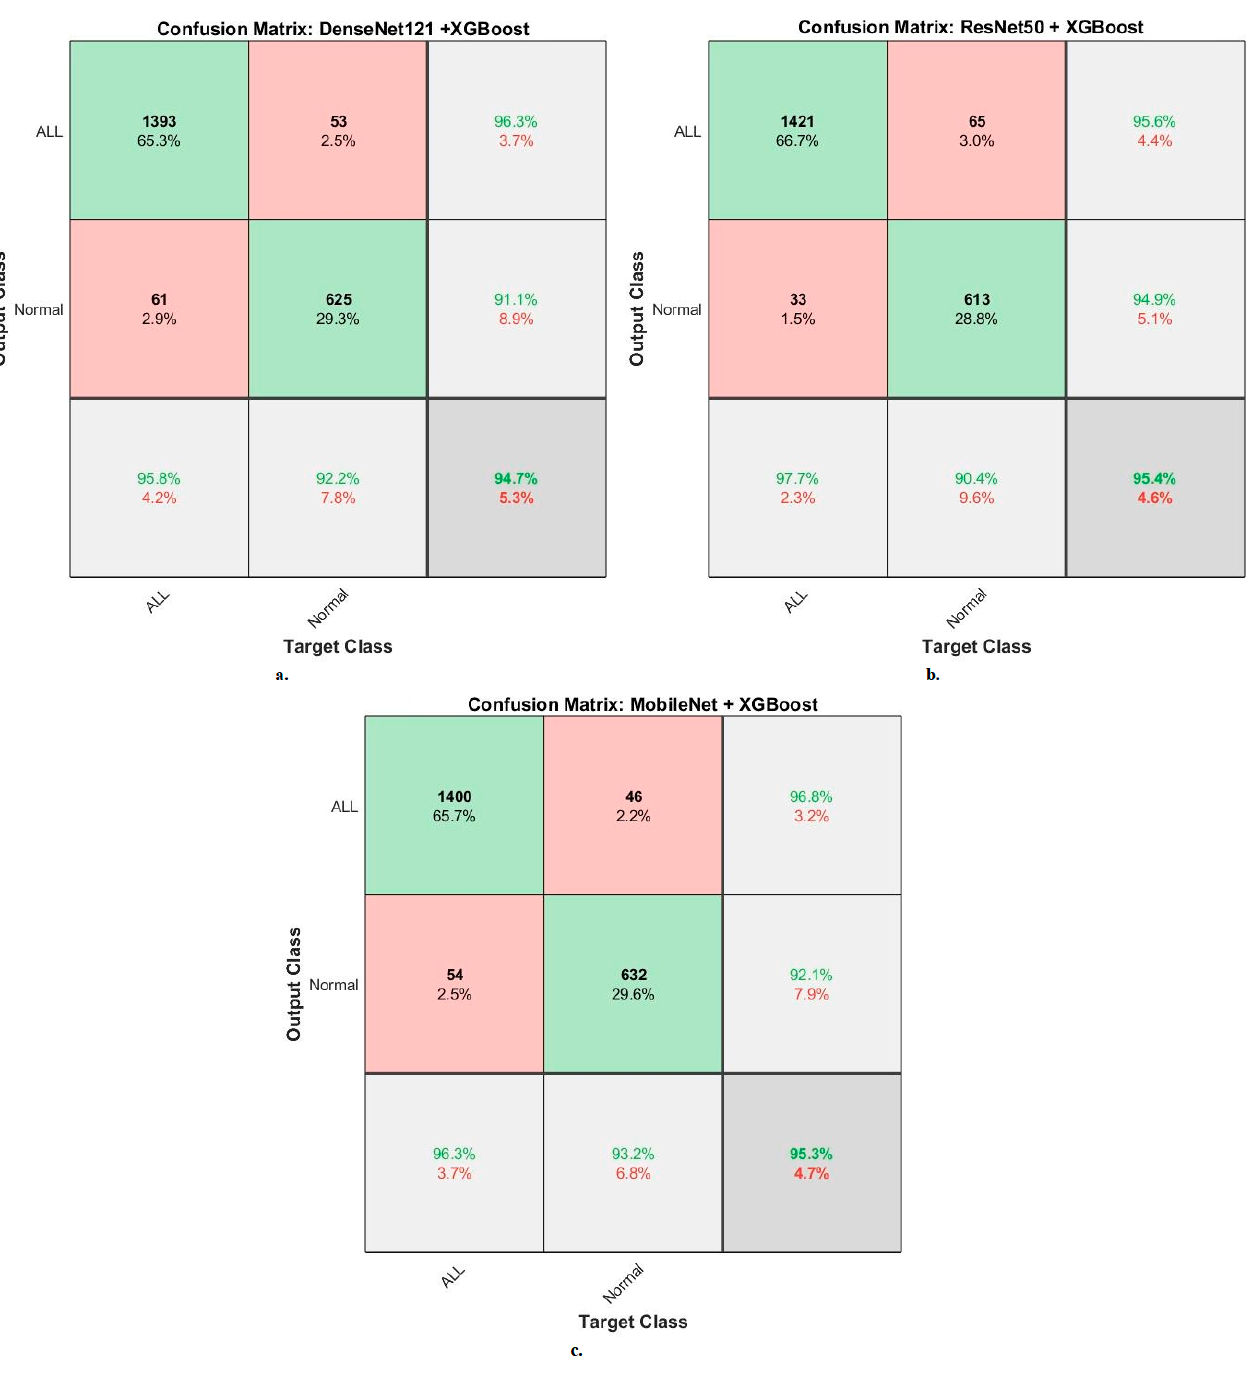
Figure 11. Results of the XGBoost classifier based on the features of the CNN models of the C-NMC 2019 dataset for the diagnosis of acute leukemia confusion matrix of ( a ) DenseNet121-XGBoost. ( b ) ResNet50-XGBoost. ( c ) MobileNet-XGBoost.